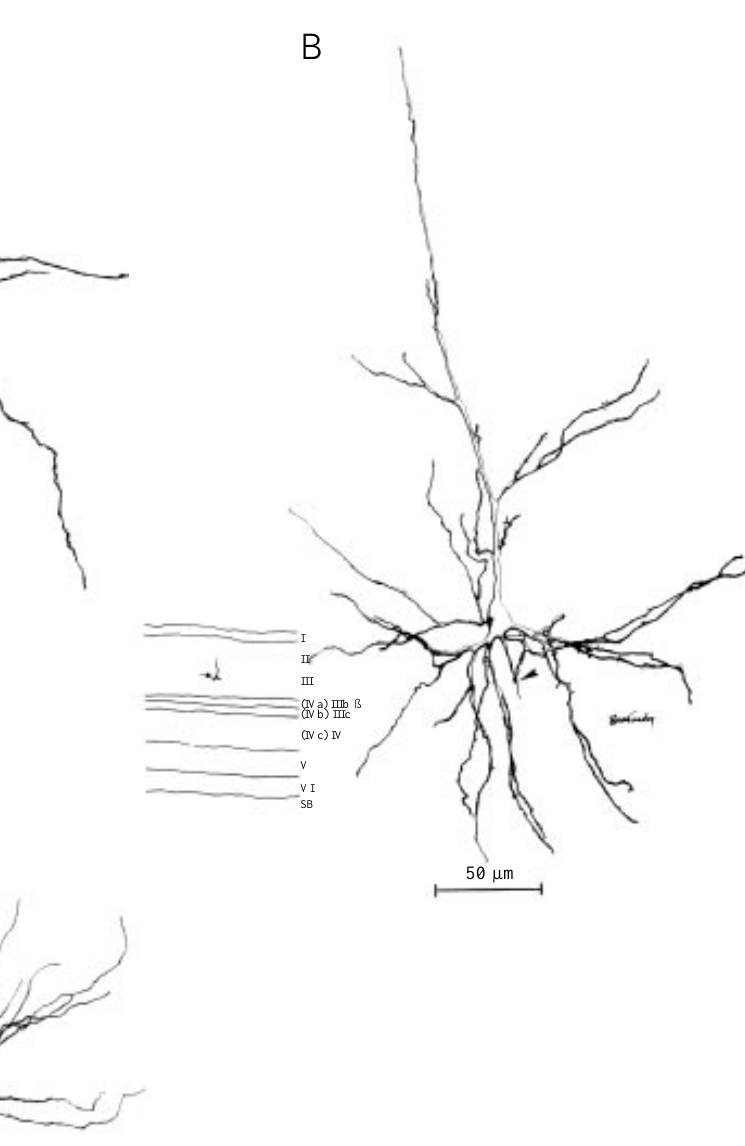
Figure 4 - Camera lucida drawings of retrogradely labeled cells of V1 after implanting biocytin gels. A, Star pyrami- dal; B , pyramidal; C , stellate neurons. Arrowheads point to axons. Insets illustrate the location of these cells relative to the cortical layers. SB, white